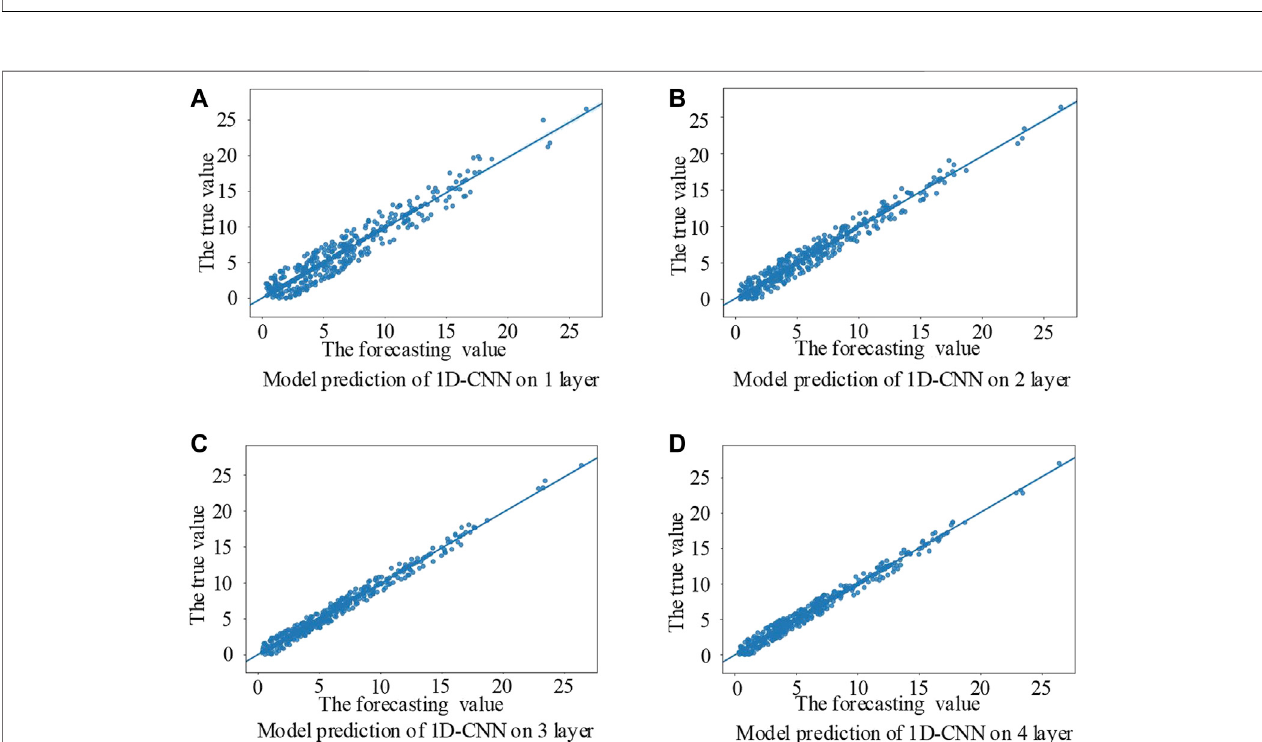
FIGURE 7 | Prediction scatter diagram of the different convolutional layer structures in the 1D-CNN model.